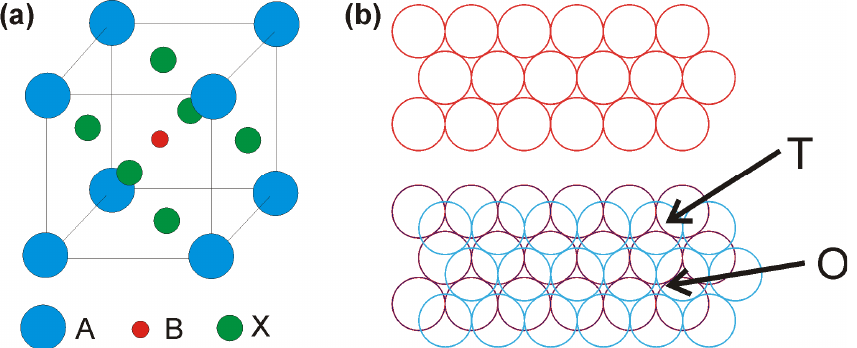
Figure 7. Schematic representations of notable inorganic structure types: ( a ) the spinel structure of a compound with composition ABX 3 and ( b ) the spinel structure consisting of layers of hexagonally arranged anions (top, schematic representation of a single layer in red) with cations located in the octahedral (O) or tetrahedral (T) holes formed between adjacent layers (bottom, schematic depiction of T and O sites between two layers, upper layer in blue).